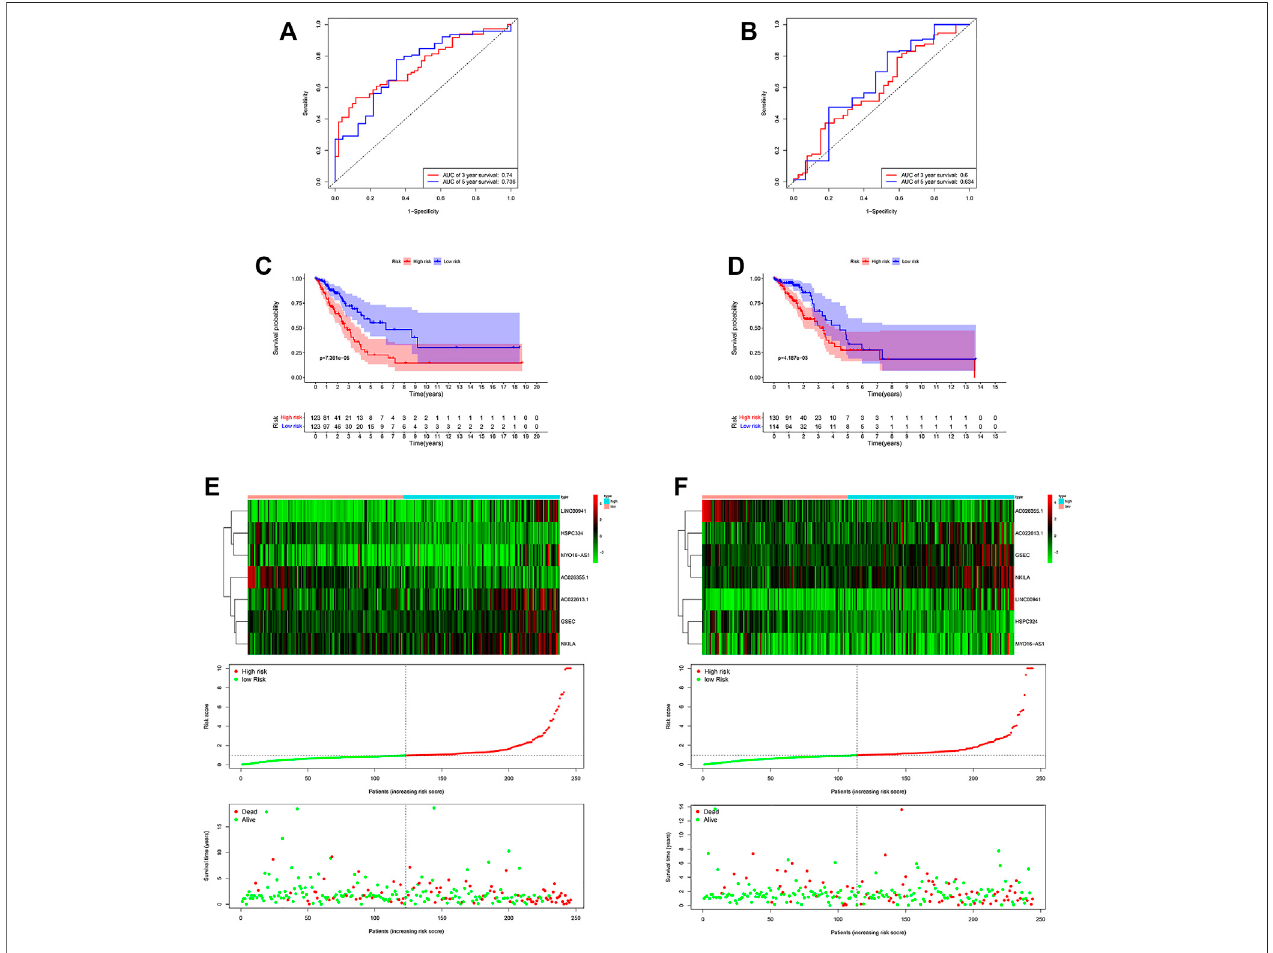
FIGURE 4 | Risk score of the hypoxia-related lncRNA signature for survival prediction in the two cohorts. The ROC analysis showed that the signature was stable (A) in the training and (B) in the validation cohorts. Between low- and high-risk groups, KM analysis was used for comparison of the OS (C) in the training and (D) validation cohorts. Distributions of risk score, survival status, and expression of lncRNAs (E) in the training, and (F) validation cohorts.